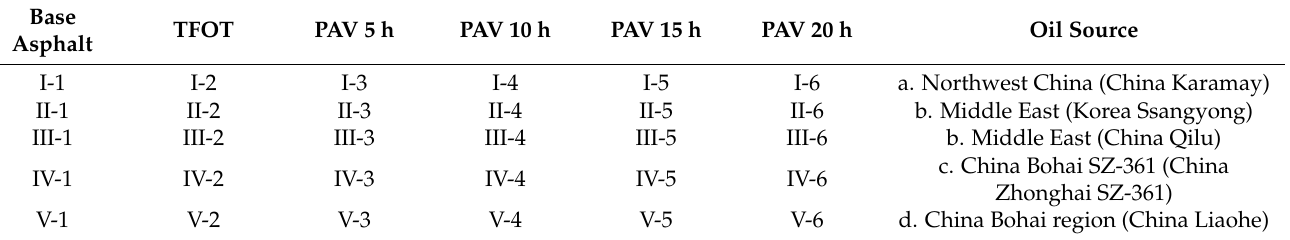
Table 1. Asphalt oil source and asphalt sample code.